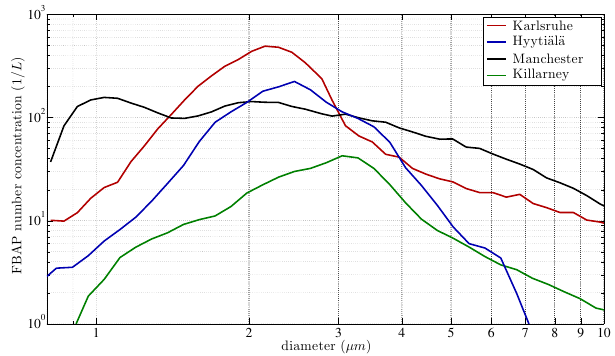
Figure 1. Average FBAP size distributions derived from UV- LIF measurements during case studies in August 2010 at Karl- sruhe (Germany) with WIBS-4, Hyytiälä (Finland) with UV-APS, Manchester (UK) with WIBS-3, and Killarney (Ireland) with UV-